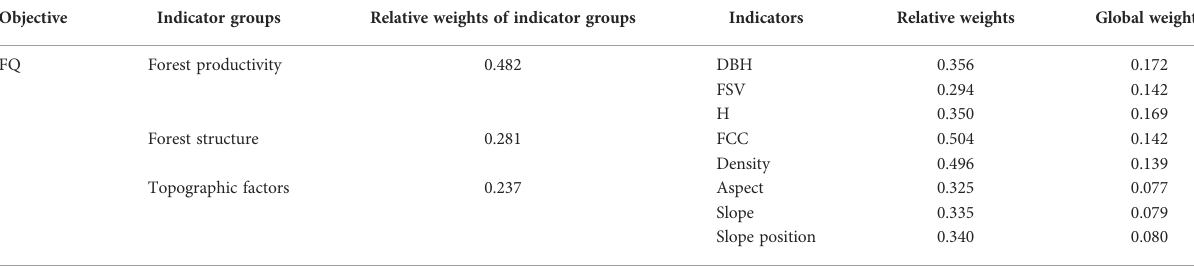
TABLE 4 FQ evaluation indicators and